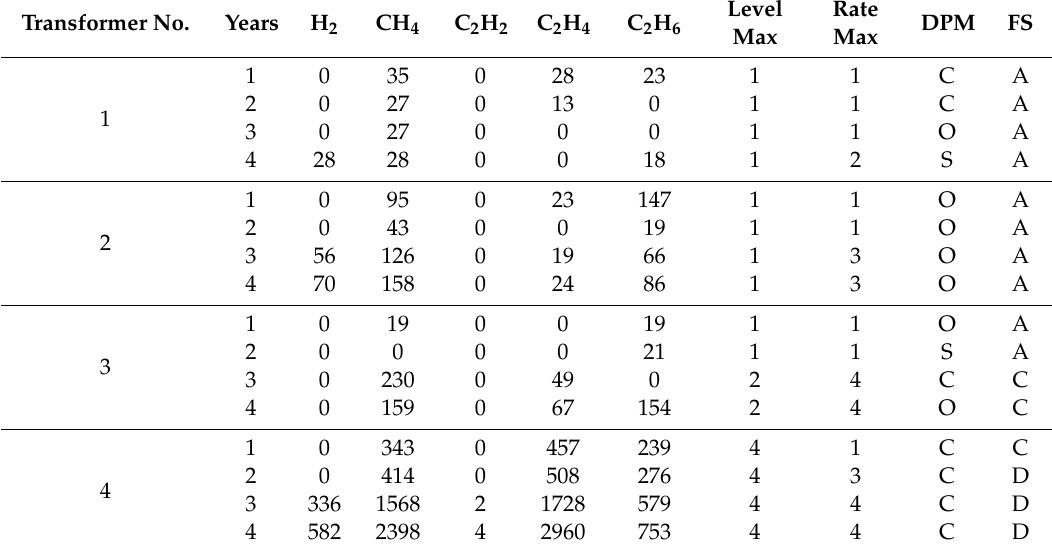
Table 14. Four years of faults’ severity determination of four power transformers. Transformer